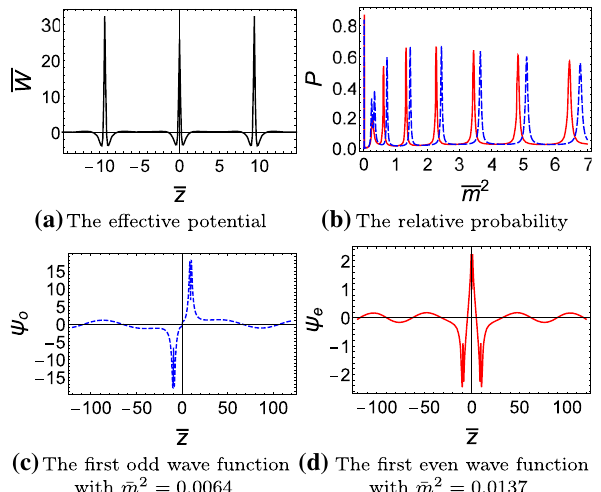
Fig. 14 The effect of the parameter ¯ α on the effective potential with ¯ b = 5 for case 2